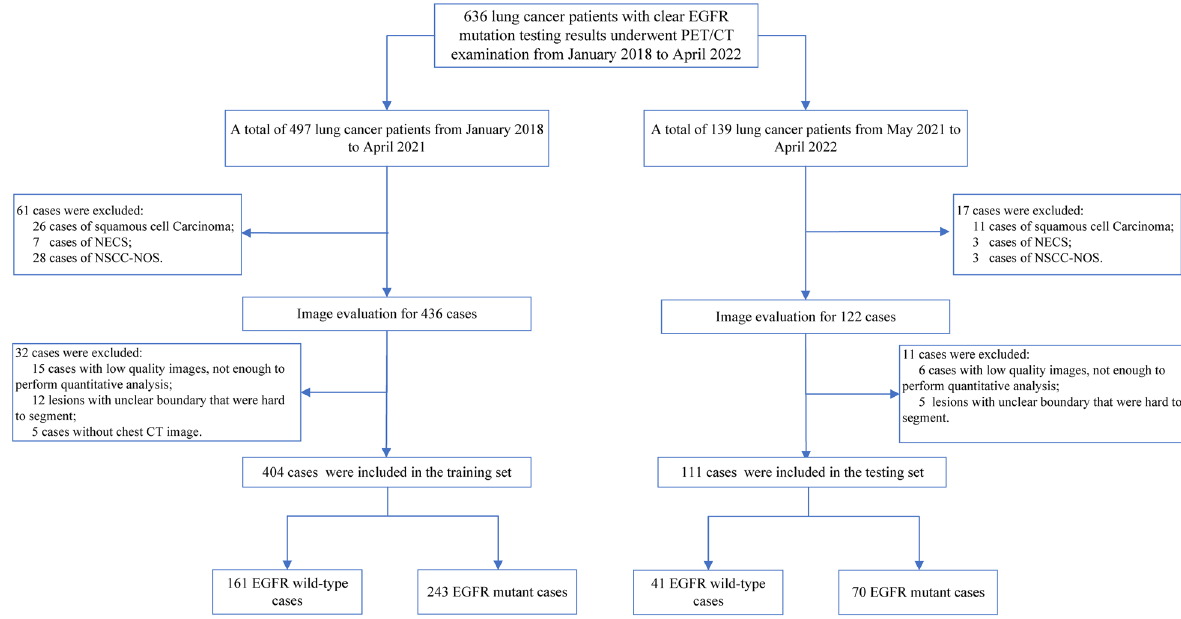
Fig. 1 Flow chart of patient selection. EGFR epidermal growth factor receptor, NECS neuroendocrine carcinomas, NSCC-NOS non-small cell carcinoma-not otherwise